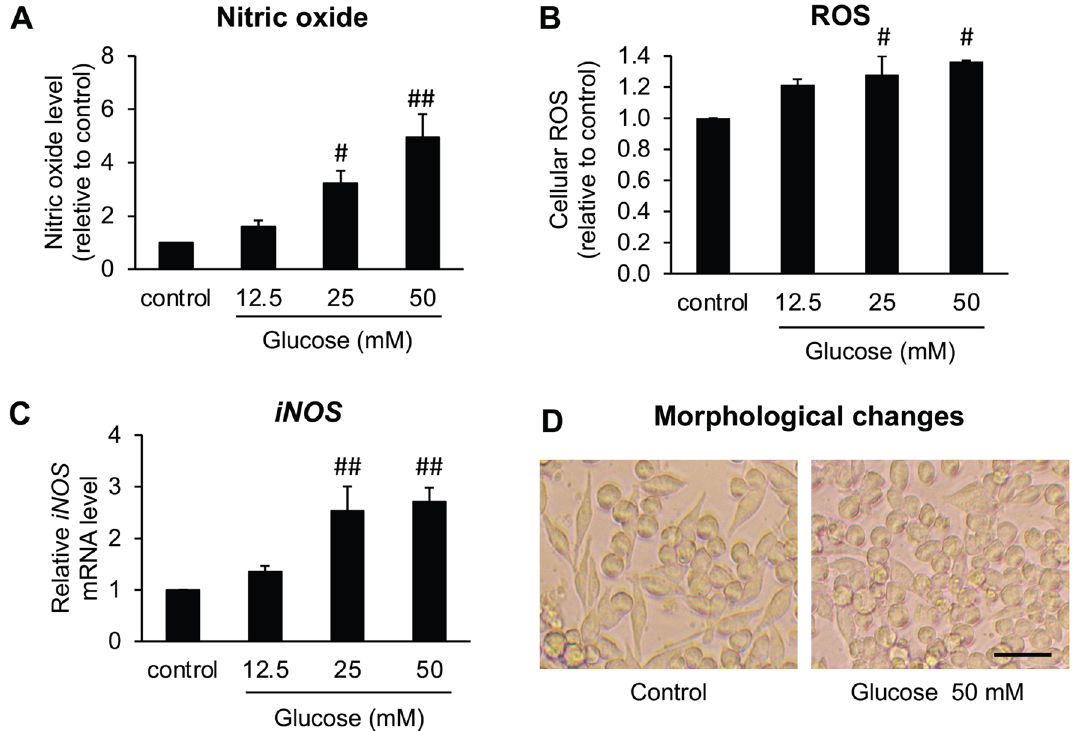
Figure 3. Effects of high glucose on features indicating microglial activation in BV2 cells, including nitric oxide (NO) release ( A ), cellular ROS generation ( B ), iNOS gene expression ( C ), and morphological alteration ( D ). Cells were incubated with either three doses of glucose (12.5, 25, 50 mM) or only 50 mM glucose for 24 or 48 h depending on the experiment. The experiments, composed of Griess’s assay, H2DCFDA assay, real-time PCR, and the observation under a light microscope, were performed to determine the level of nitric oxide, cellular ROS, iNOS mRNA, and also the morphological alteration, respectively. In morphological observation, photos were taken at ×20 magnification and selected from one experiment as a representative from three independent experiments. The scale bar is 50 μm. The values are demonstrated as the mean ± SEM from three